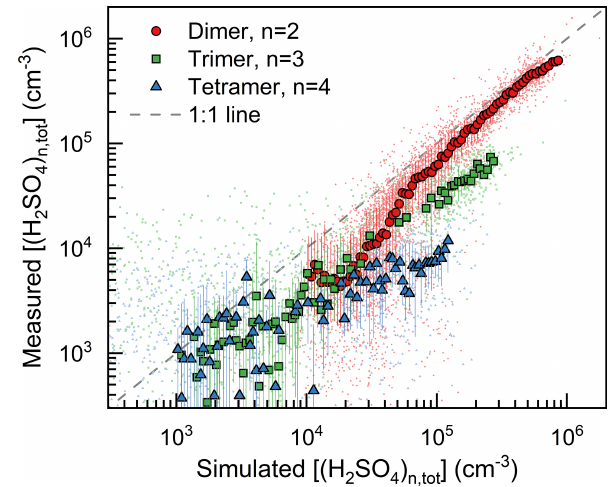
Figure 1. H 2 SO 4 dimer concentration for urban Beijing. [(H 2 SO 4 ) 1 , tot ] and [(H 2 SO 4 ) 2 , tot ] are the measured H 2 SO 4 monomer and dimer concentrations, respectively. The horizontal axis is proportional to the theoretical steady-state H 2 SO 4 dimer concentration at given amine concentrations. The measured raw data on NPF days with a temporal resolution of 5min are shown with small dots. The median values of these dots grouped by the horizontal coordinate are shown with big red markers, and the er- ror bars indicate the lower and upper quartiles. The condensation sink (CS) and temperature for the simulated formation rate are their median values during the observed NPF events, i.e., 0.017s − 1 and 281K, respectively. The amine-saturated limit (dashed black line) is simulated at an ultrahigh DMA concentration (10 6 ppt), so the evap- oration rates of H 2 SO 4 –DMA clusters are negligible compared to their formation rates. The R 2 value was calculated using logarith- mic values.